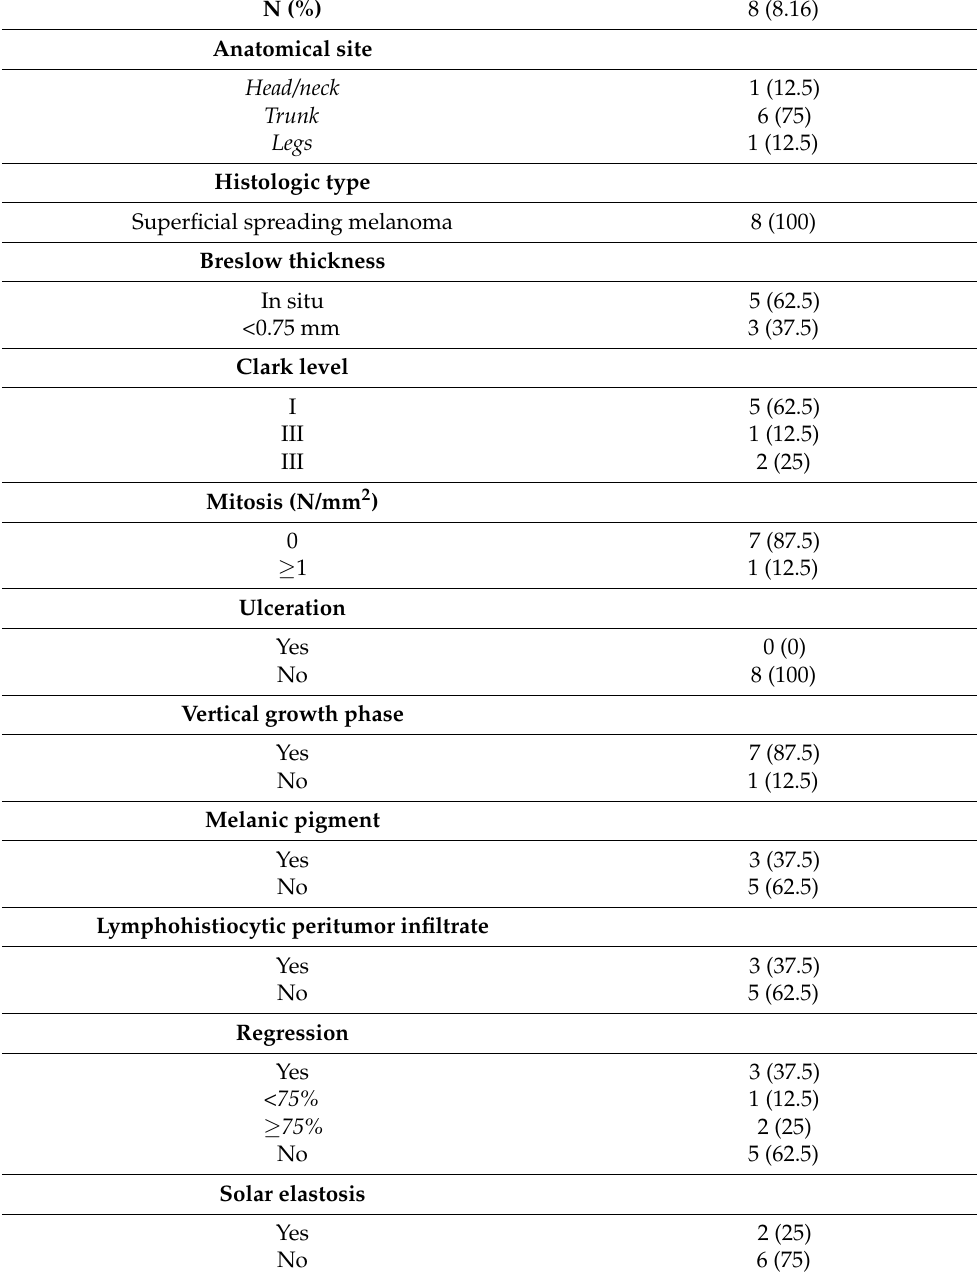
Table 4. Clinical and Histological characteristics of melanoma in patients with